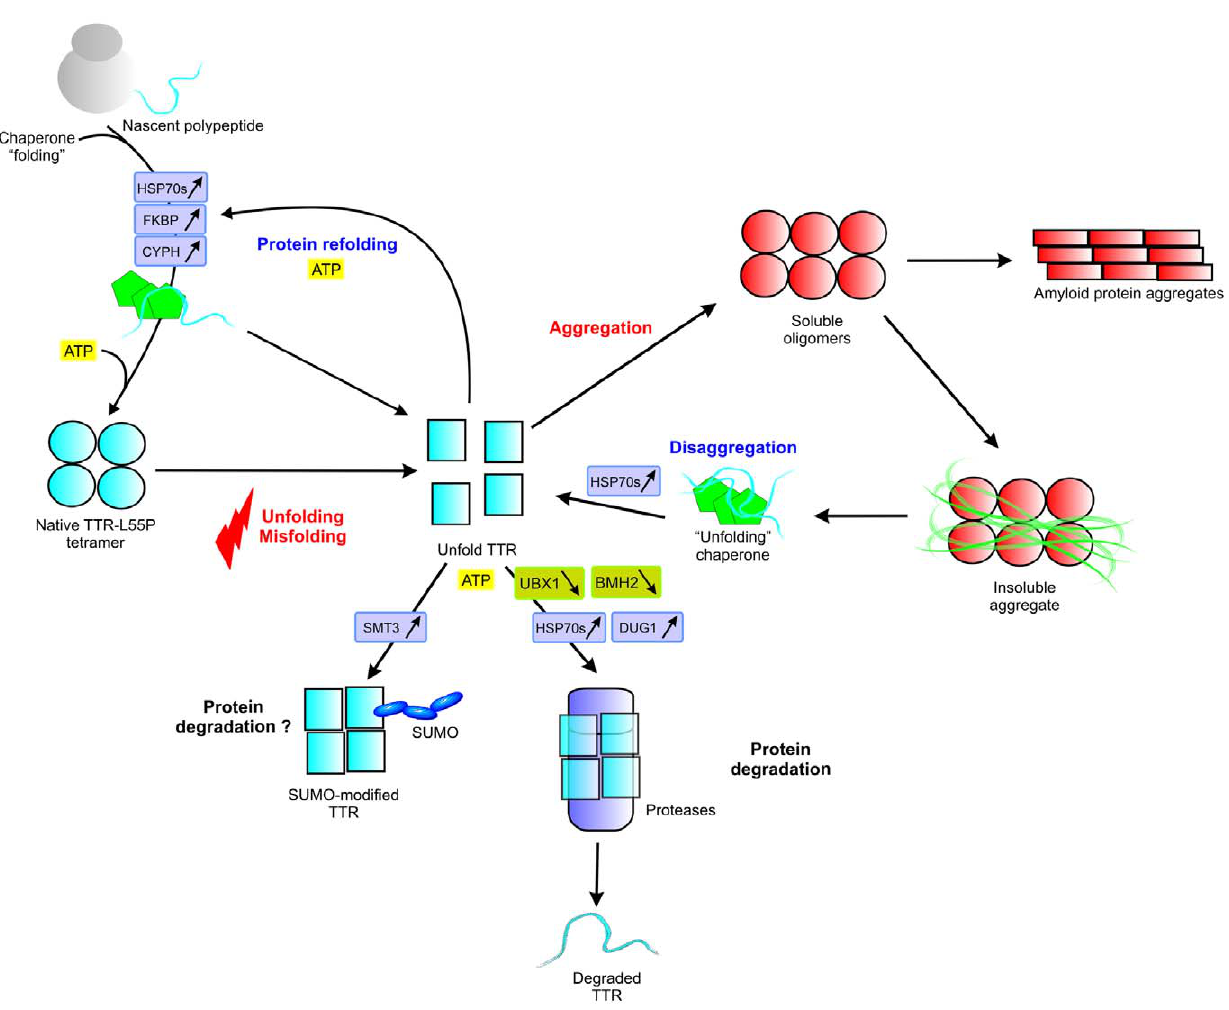
Figure 7. TTR misfolding and protein quality control mechanisms. Differentially expressed proteins are highlighted, those induced framed in purple and those repressed are framed in green. Protein full names are indicated in Table 1.